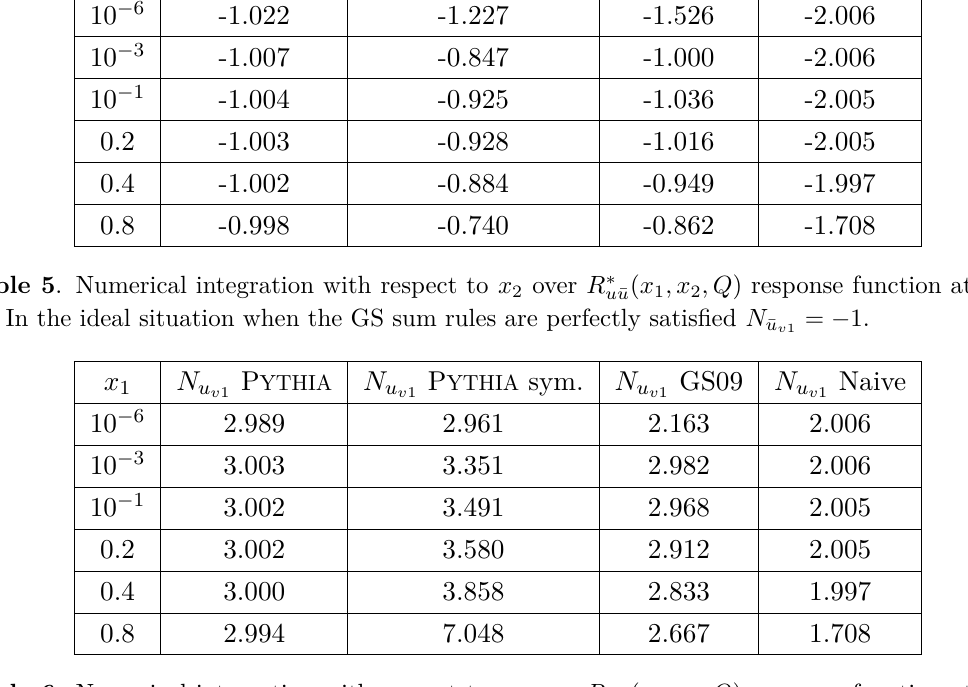
Table 6 . Numerical integration with respect to x 2 over R ¯ uu ( x 1 , x 2 , Q ) response function at